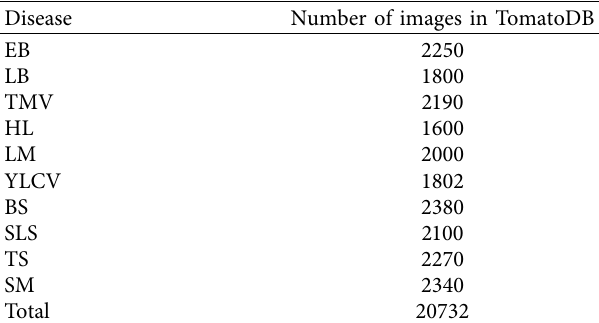
Table 2: TomatoDB images and different diseases’ statistics. Disease